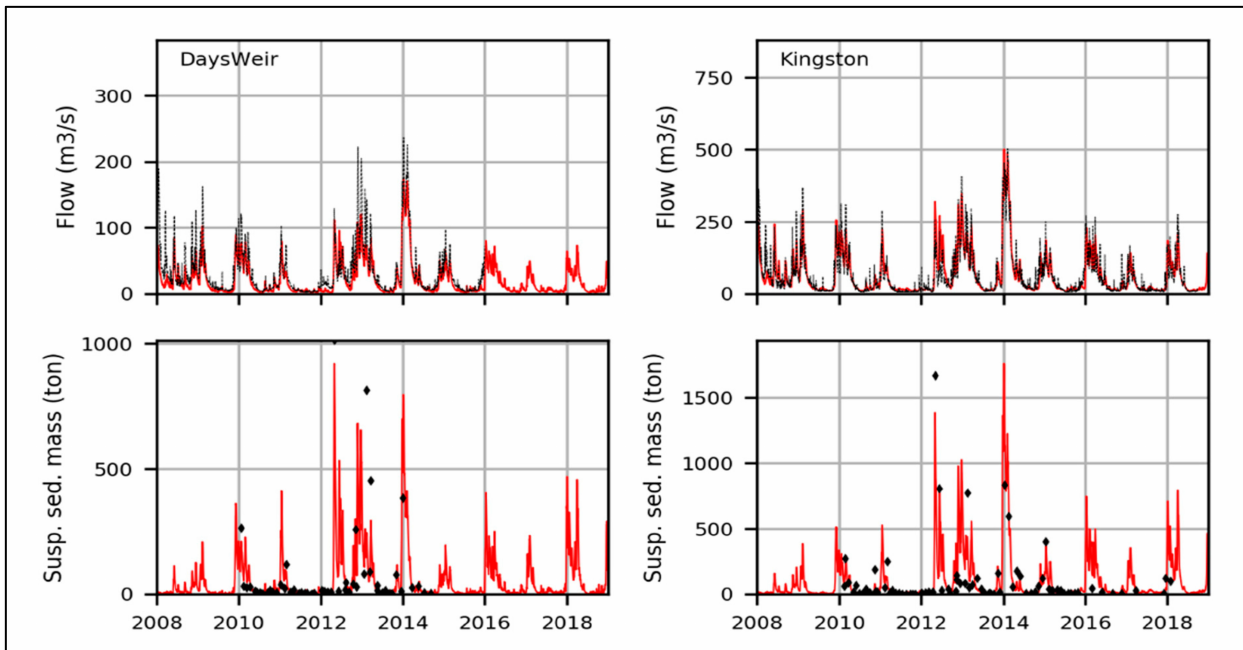
Figure 2. Calibration (2008–2012) and validation (2013–2018) results of the INCA microplastics model in the River Thames at two stations (Days Weir and Kingston), in terms of flow (upper plots) and sediment mass (lower plots). Black: observed, red: